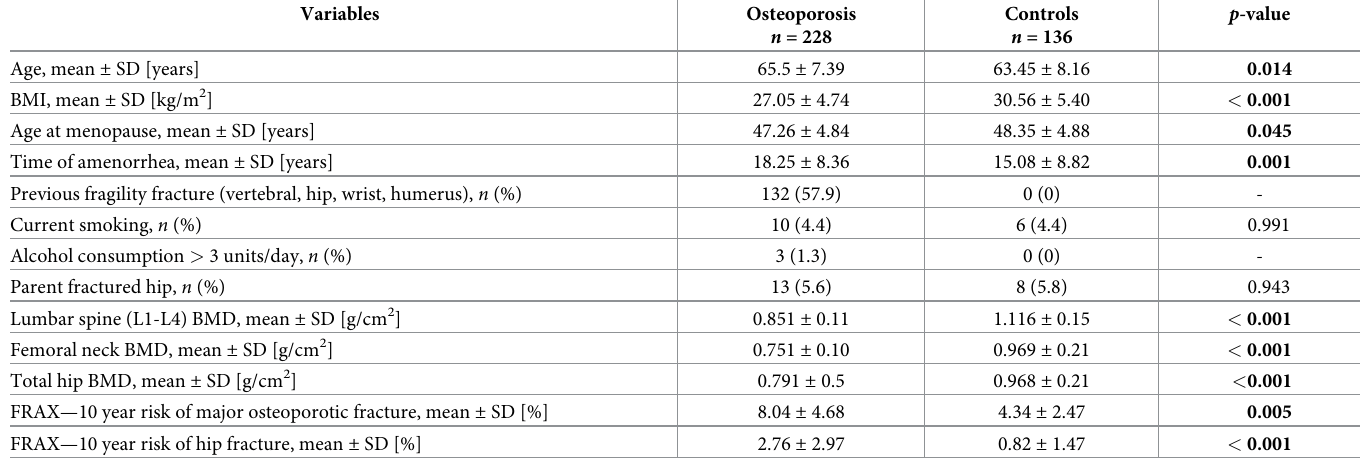
Table 1. Clinical characteristics of women included in the